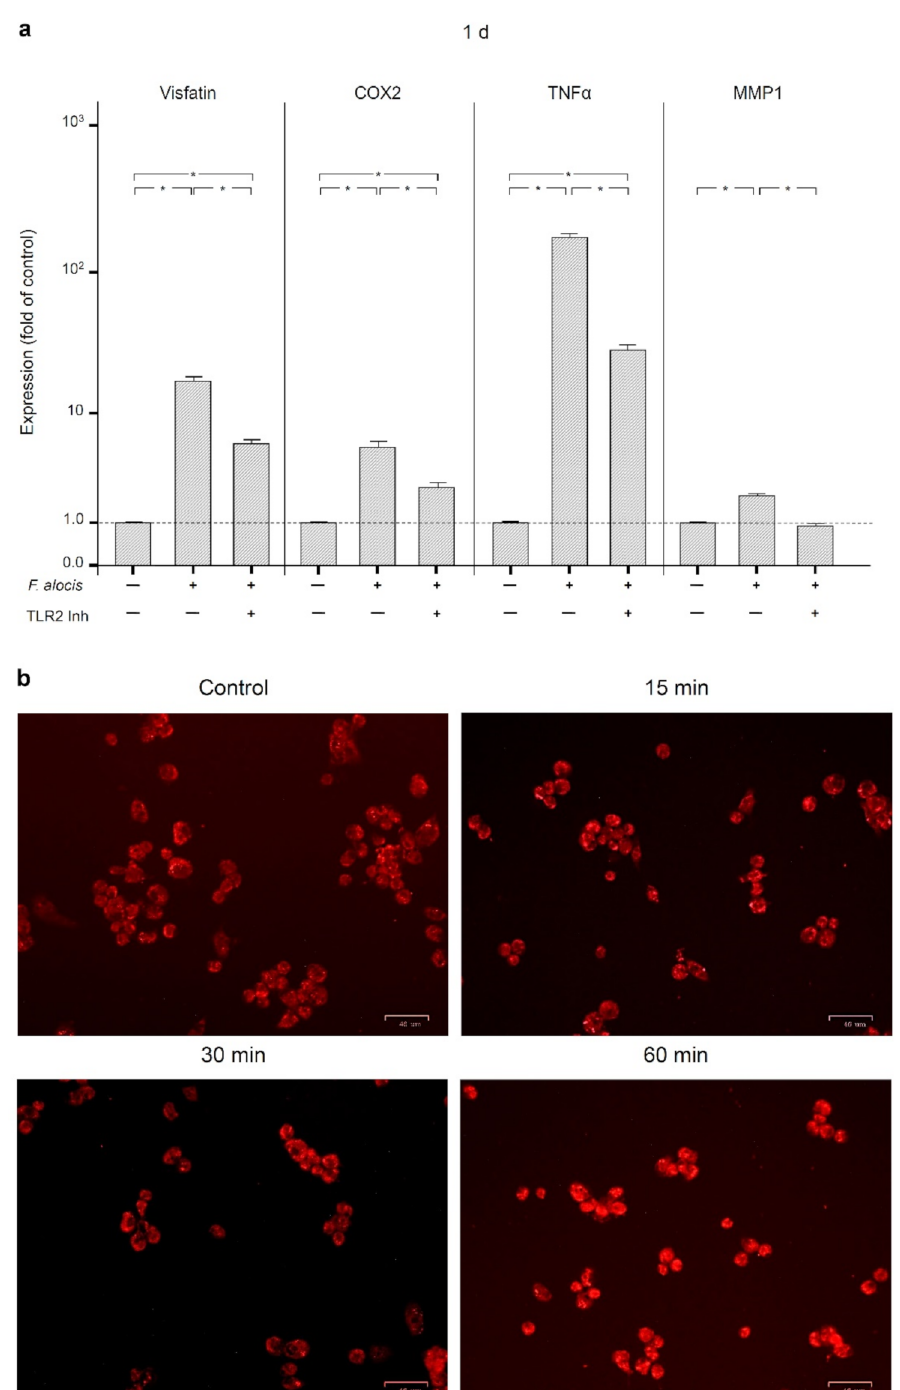
Figure 4. Expression of visfatin, COX2, TNF α , and MMP-1 in response to F. alocis (OD 660 : 0.1) in the presence and absence of anti-TLR2 blocking antibody in human macrophages at 1 d, as analyzed by real-time PCR ( a ). Mean ± SEM, n = 3/group. * significant ( p < 0.05) difference between groups. NF- κ B (p65) nuclear translocation in human macrophages stimulated or not with F. alocis (OD 660 : 0.1) over 60 min, as examined by immunofluorescence microscopy ( b ). Shown are representative images from one of three